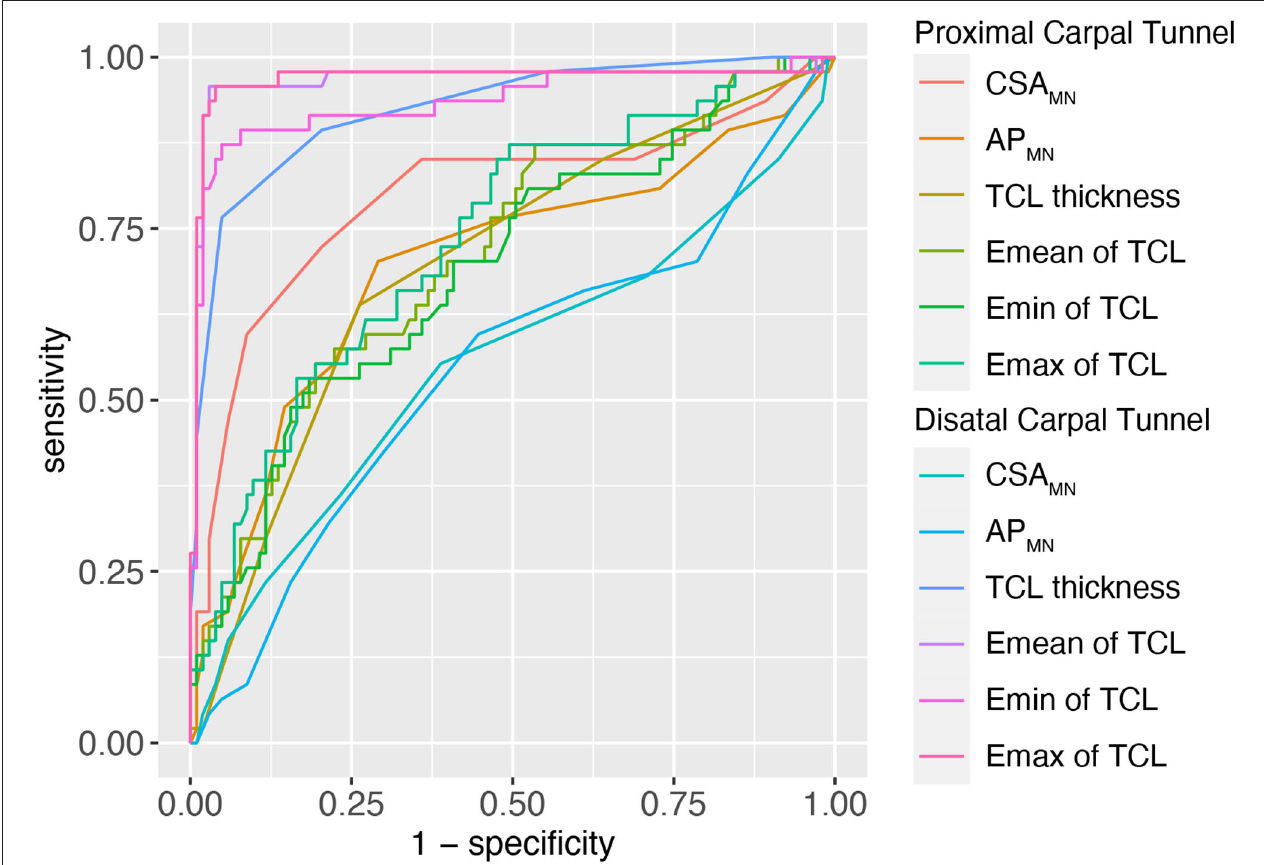
FIGURE 3 | The ROC of MN (CSA and thickness) and TCL (thickness and stiffness) at proximal and distal carpal tunnel to diagnose CTS. TCL, transverse carpal ligament; CSA, cross sectional area; MN, median nerve; SWE, Shear wave elastography; ROC, receiver operating characteristic curve.